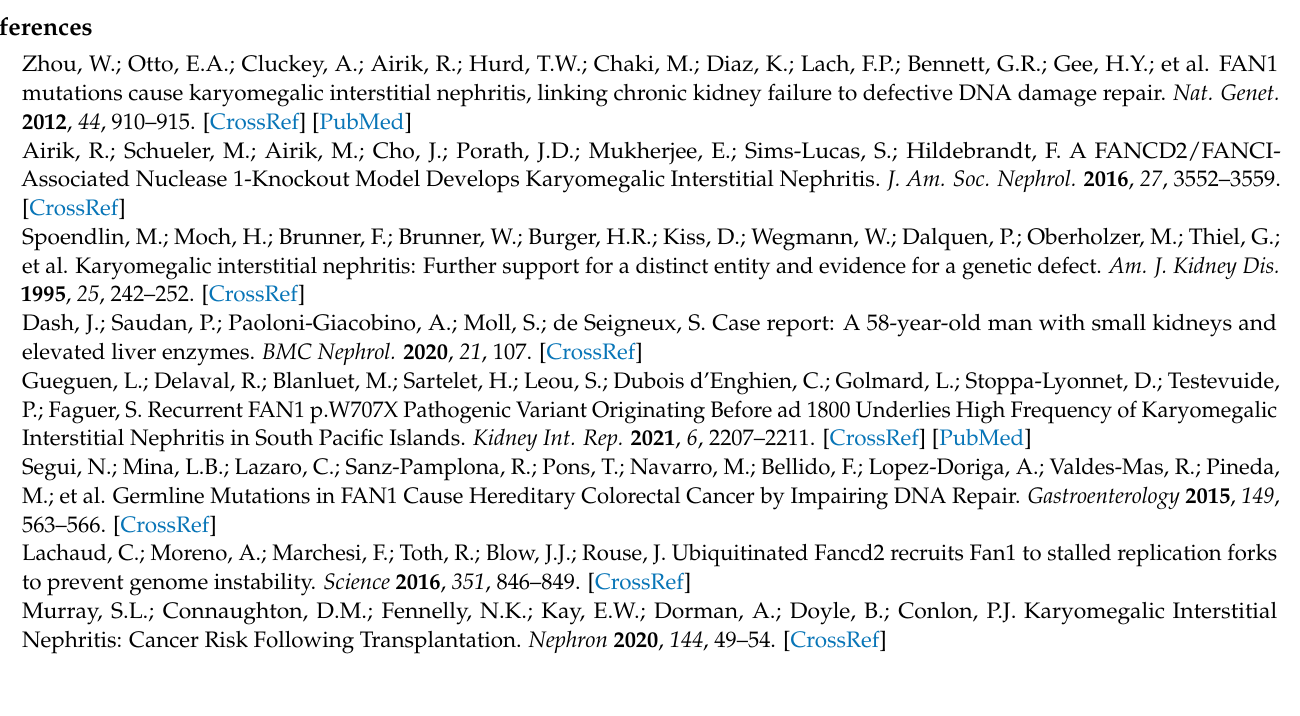
Figure S7: JP4-039 suppresses oxidative stress and DNA damage in cisplatin-treated FAN1-null kidneys; Figure S8: JP4-039 prevents the loss of FAO enzymes in cisplatin-treated FAN1-null kidneys; Table S1: List of antibodies and lectins used in the study; Table S2: List of genotyping and quantitative RT-PCR primers and NCBI gene accession